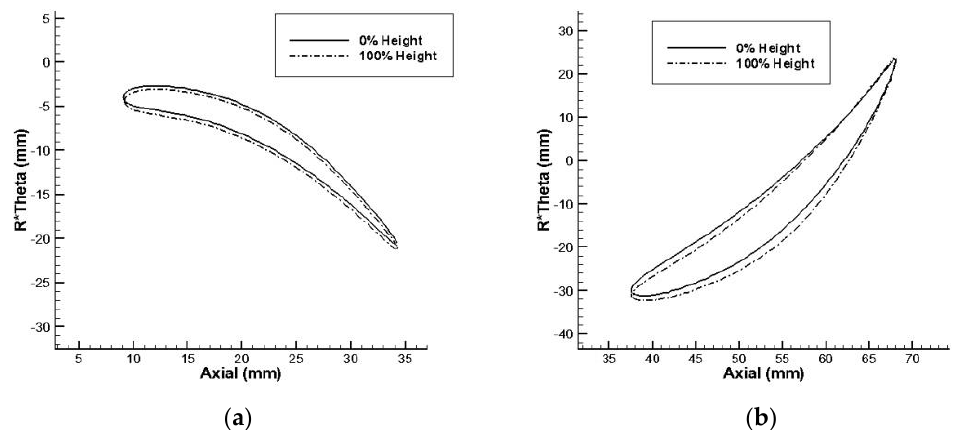
Figure 9. The profiles of the designed high-reaction tip turbine: ( a ) profiles of the stator; ( b ) profiles of